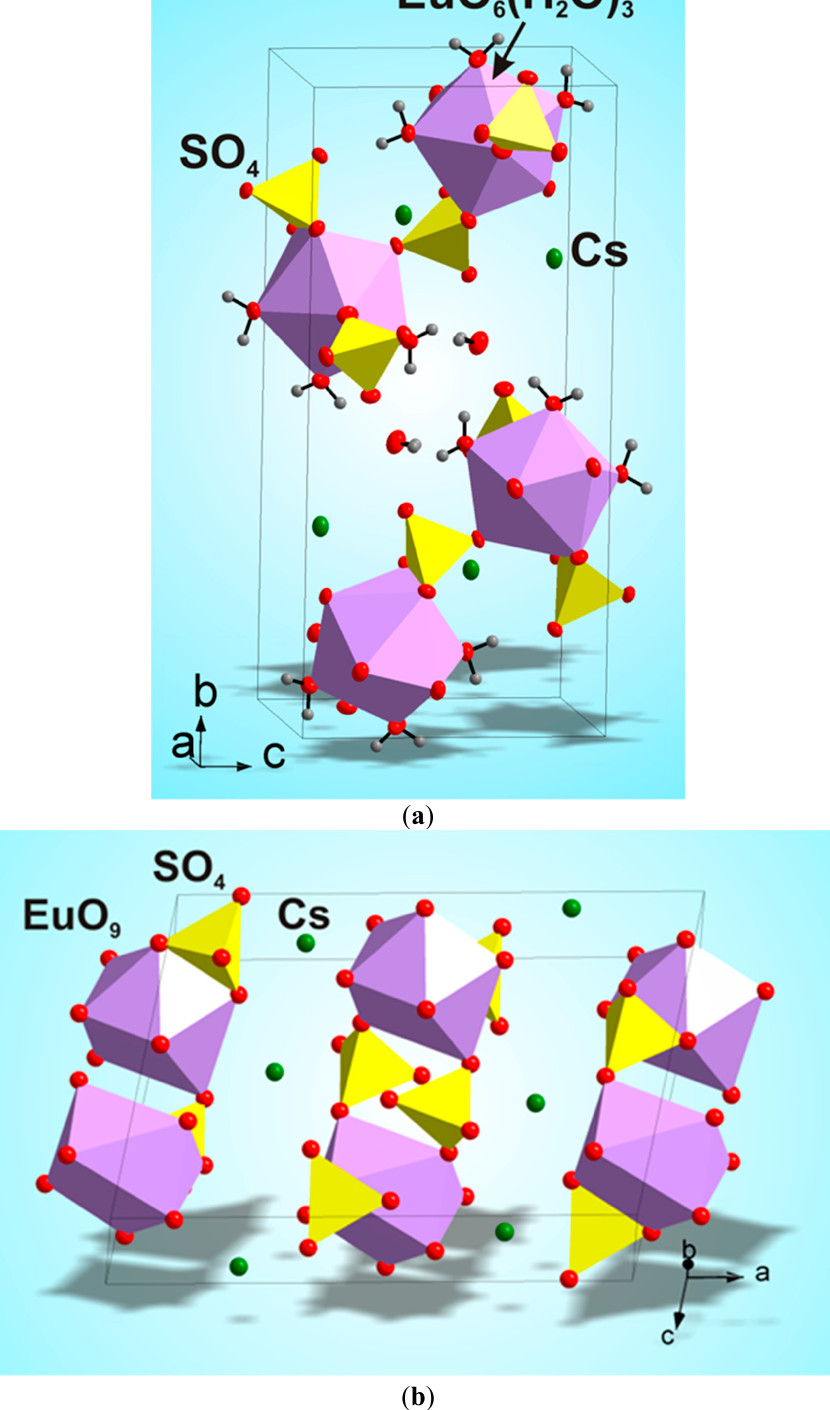
Figure 3. Crystal structures of ( a ) [CsEu(H 2 O) 3 (SO 4 ) 2 ]·H 2 O and ( b ) CsEu(SO 4 ) 2 . The unit cells are outlined.